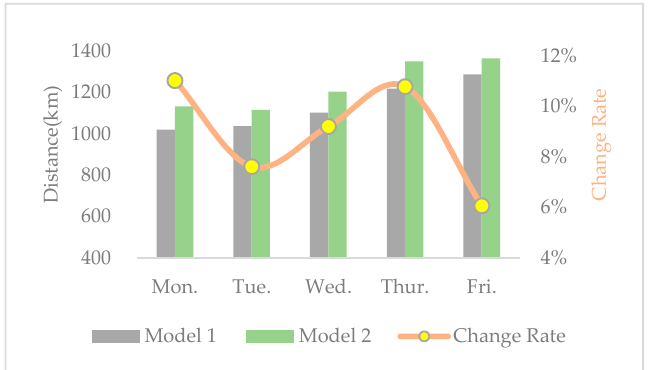
Figure 5. Distance and change rate in the two models.